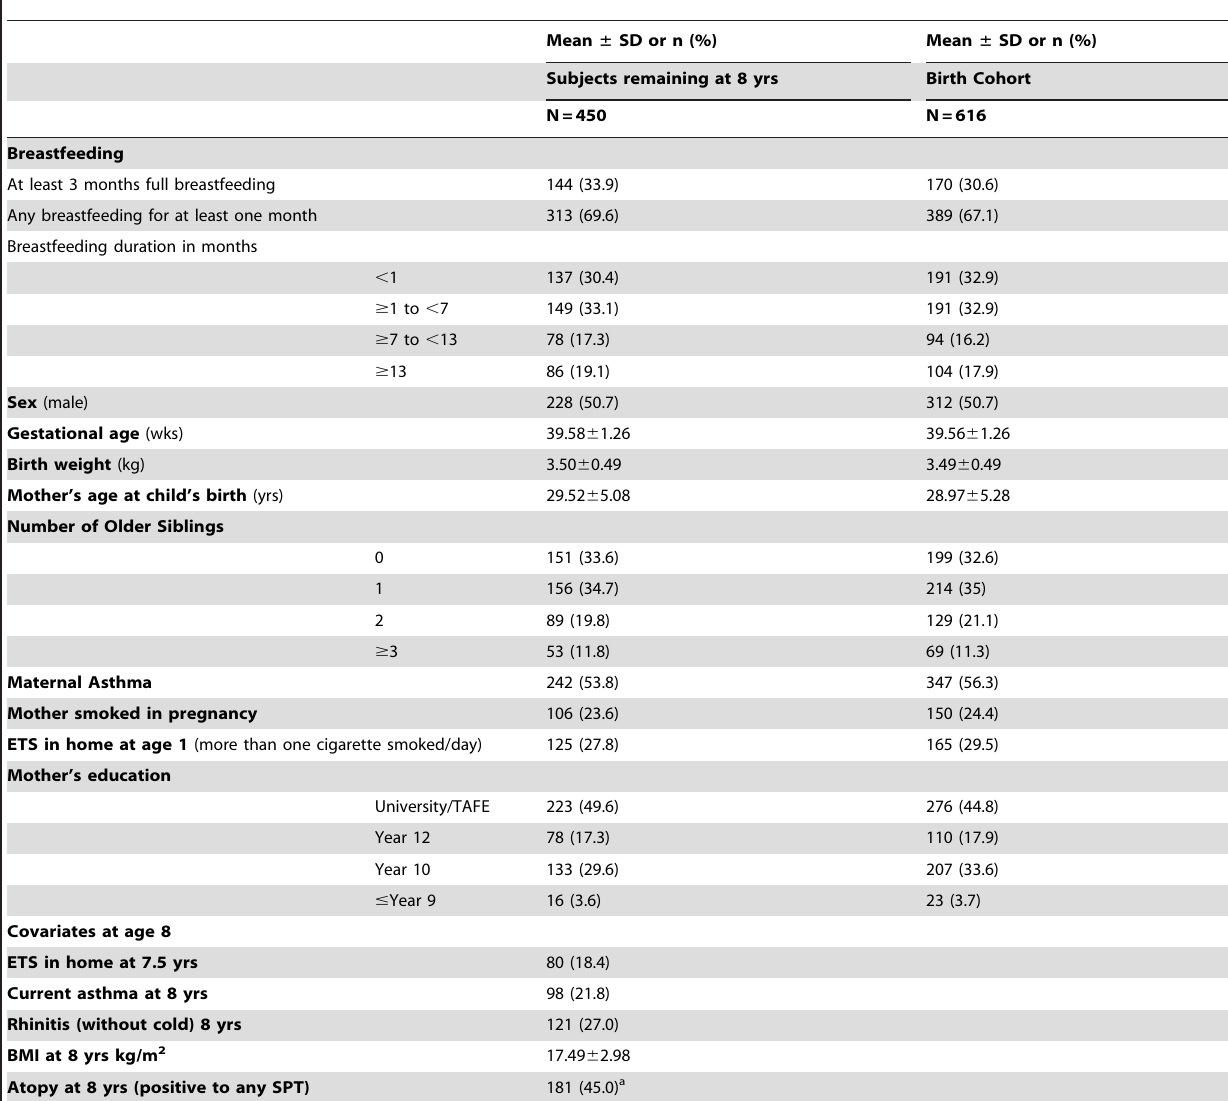
Table 1. Characteristics of CAPS subjects assessed at 8 years and of the original cohort recruited